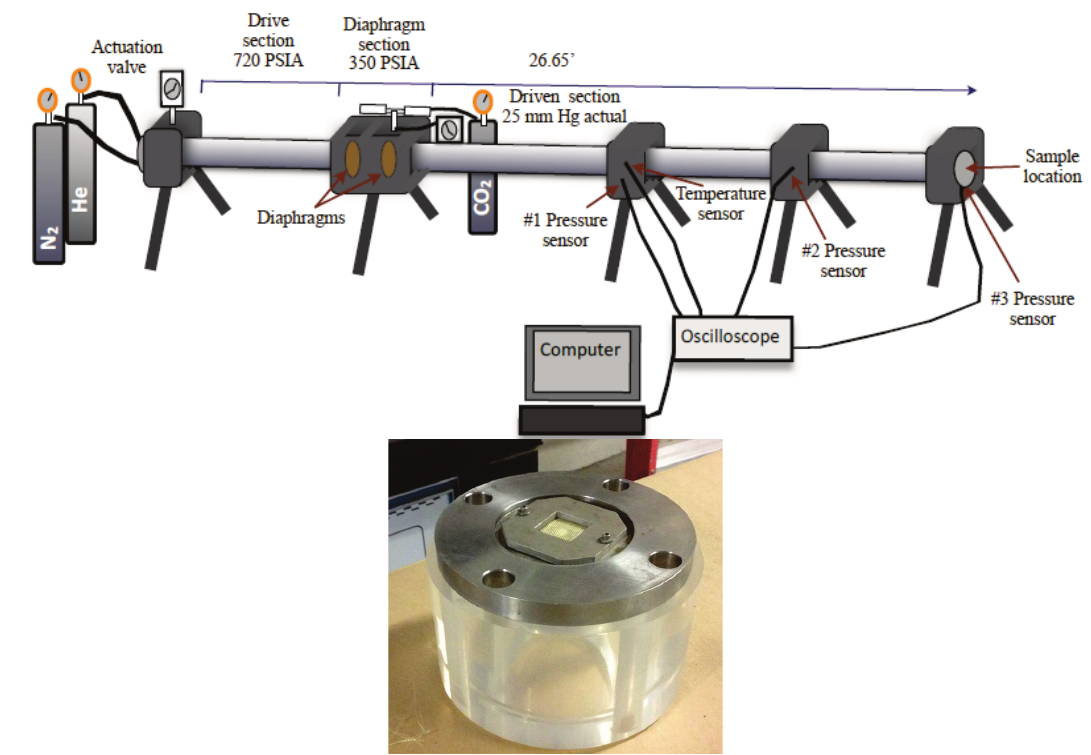
Figure 11. Shock tube setup ( top ) and image of the sample contained with Kevlar ( bottom ).